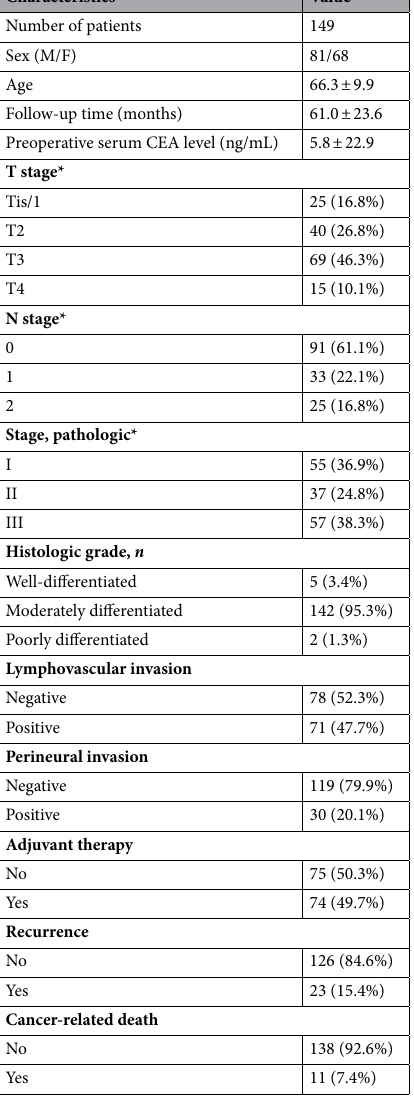
Table 1. Patient characteristics. Values are presented as means ± standard deviation or numbers of patients. CEA carcinoembryonic antigen. *According to the American Joint Committee on Cancer (AJCC) 7th